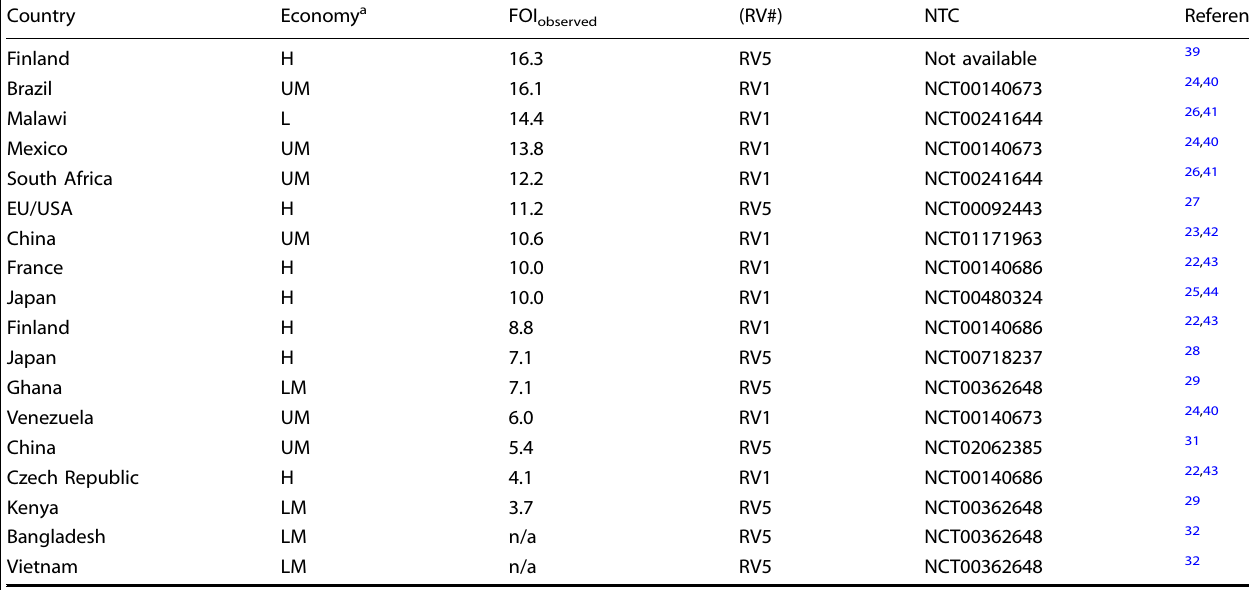
Table 1. Rotavirus vaccine Phase 3 study settings by country, World Bank country income classi fi cation, and surrogate observed force of infection. Country Economy